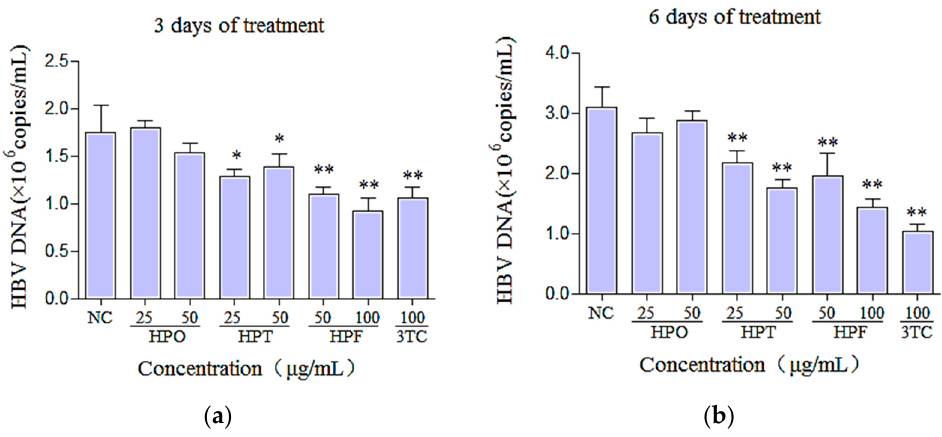
Figure 4. Inhibitory effects of HPO, HPT, HPF and 3TC on the expression of HBV DNA in the supernatant. HepG2.2.15 cells were treated in the presence of different concentrations of HPO, HPT, or HPF or 100 μ g/mL 3TC for ( a ) three days and ( b ) six days. The levels of HBV DNA in the supernatant were quantified using reverse transcriptase (RT)-PCR. A negative control (with no drug treatment) was treated with vehicle. The results are presented as the means ± SD. ** p < 0.01, * p < 0.05 vs. negative control.